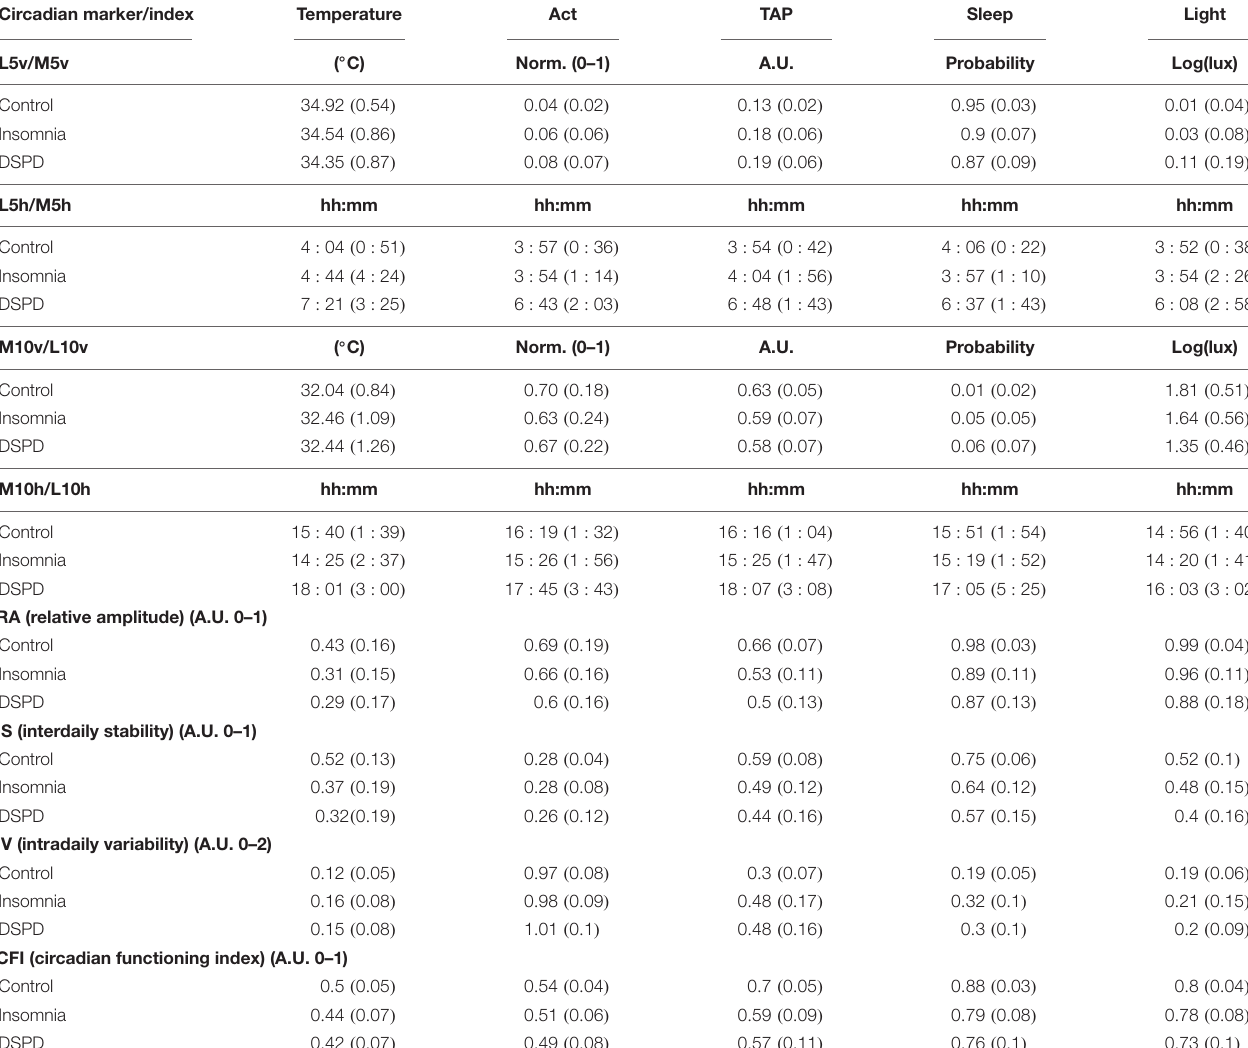
TABLE 1 | Mean value (standard deviations in brackets) for every index obtained from non-parametric analysis for wrist temperature, motor activity, TAP, estimated sleep, and environmental light. Circadian marker/index Temperature Act TAP Sleep Light